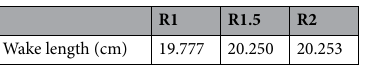
Table 2. Average magnitude of the wake